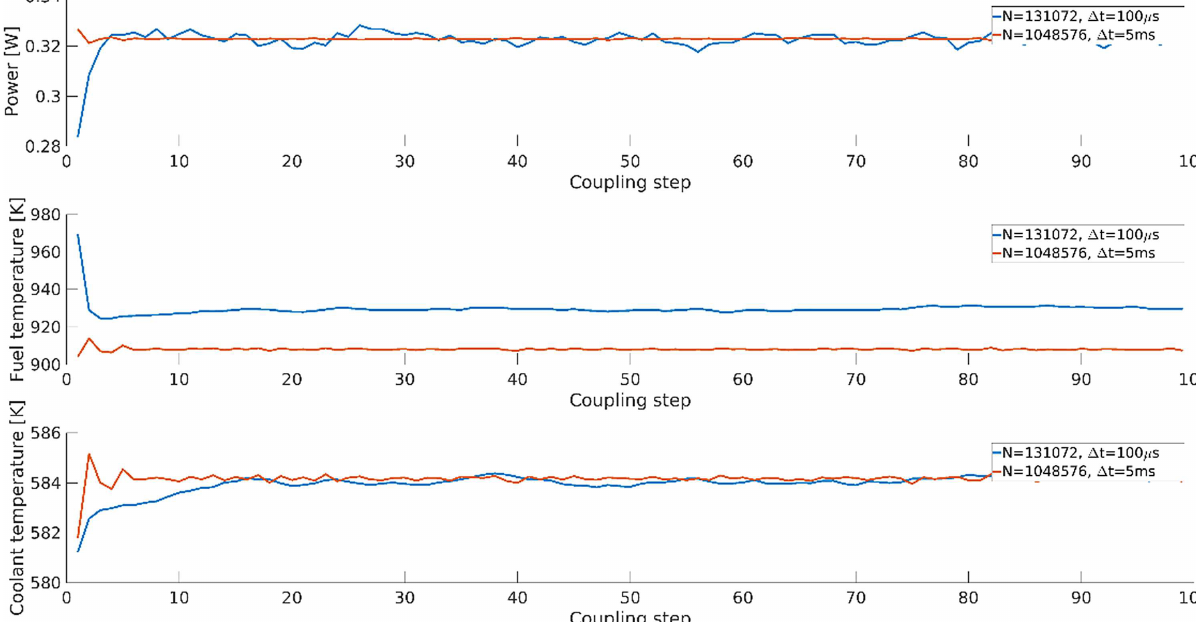
Fig. 5. Source convergence in dynamic mode, power is normalized to a single starting